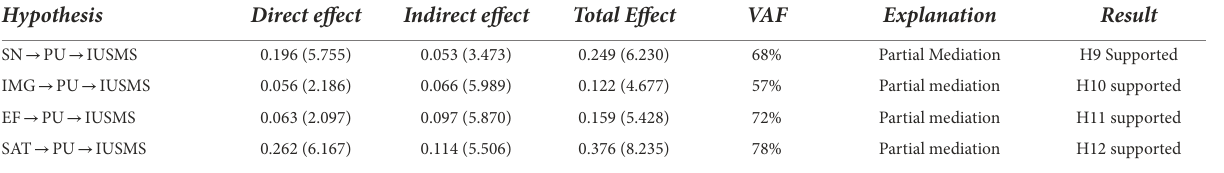
TABLE 6 Mediation